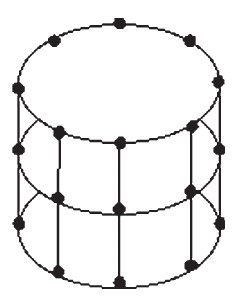
Fig. 2. Slicing and sectioning the peg for haptic collision detection.